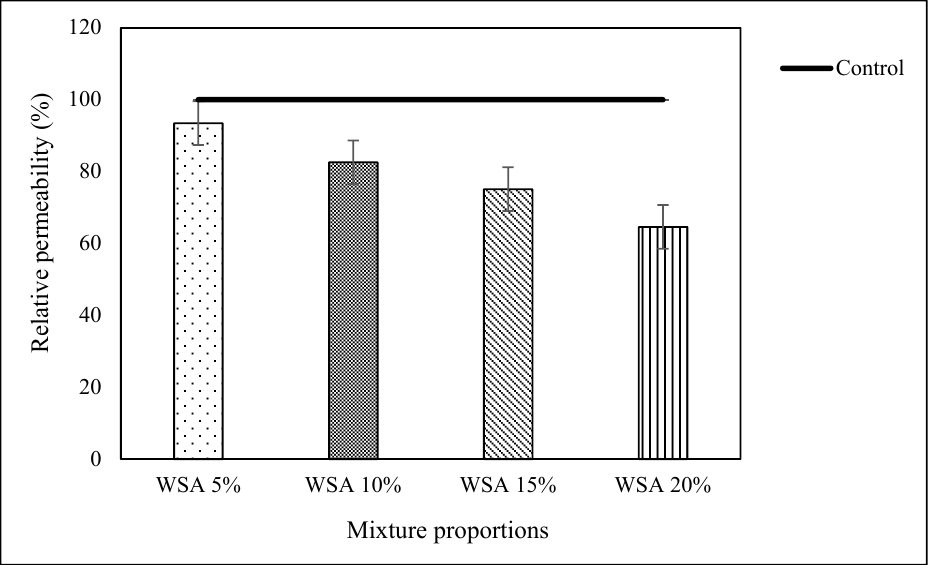
Figure 10. Relative permeability of concrete with wheat straw ash and replacement ratio of cement with wheat straw ash.